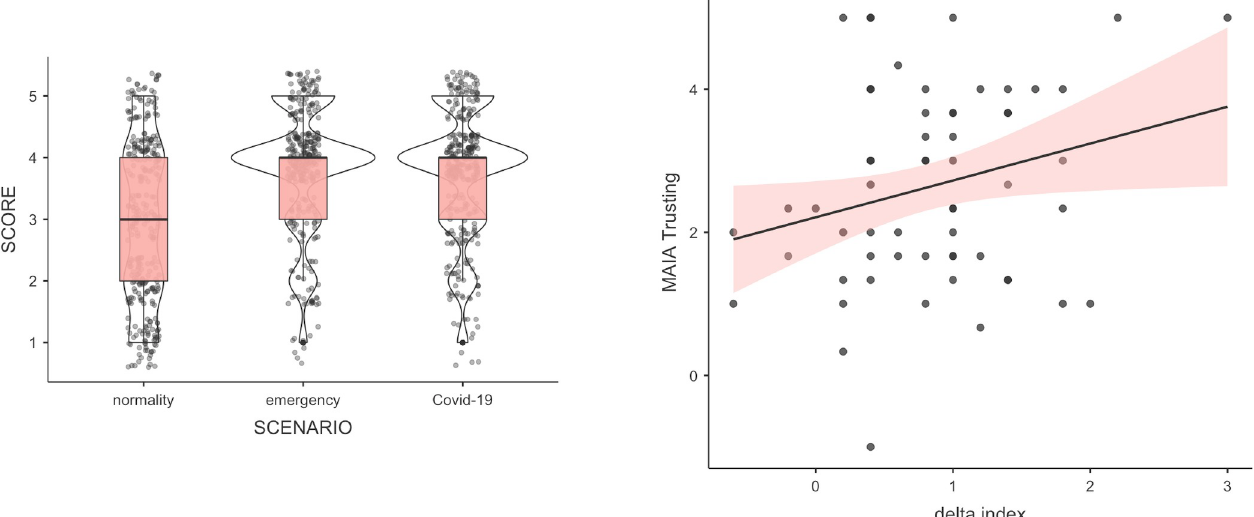
Fig 1. Results. The left panel shows the distribution of raw scores in the three conditions. The right panel shows the results of the regression analysis between the subscale of the MAIA (Trusting) and the delta values of the legitimacy index (difference between perceived legitimacy scores in the COVID-19 and Normality